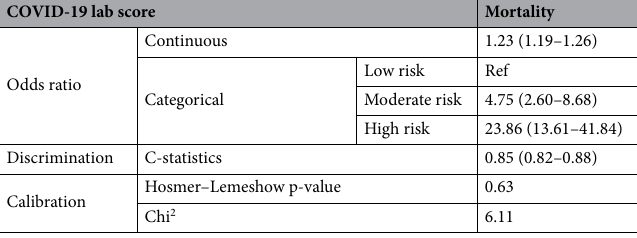
Table 5. Predictive ability of COVID-19 lab score for mortality.